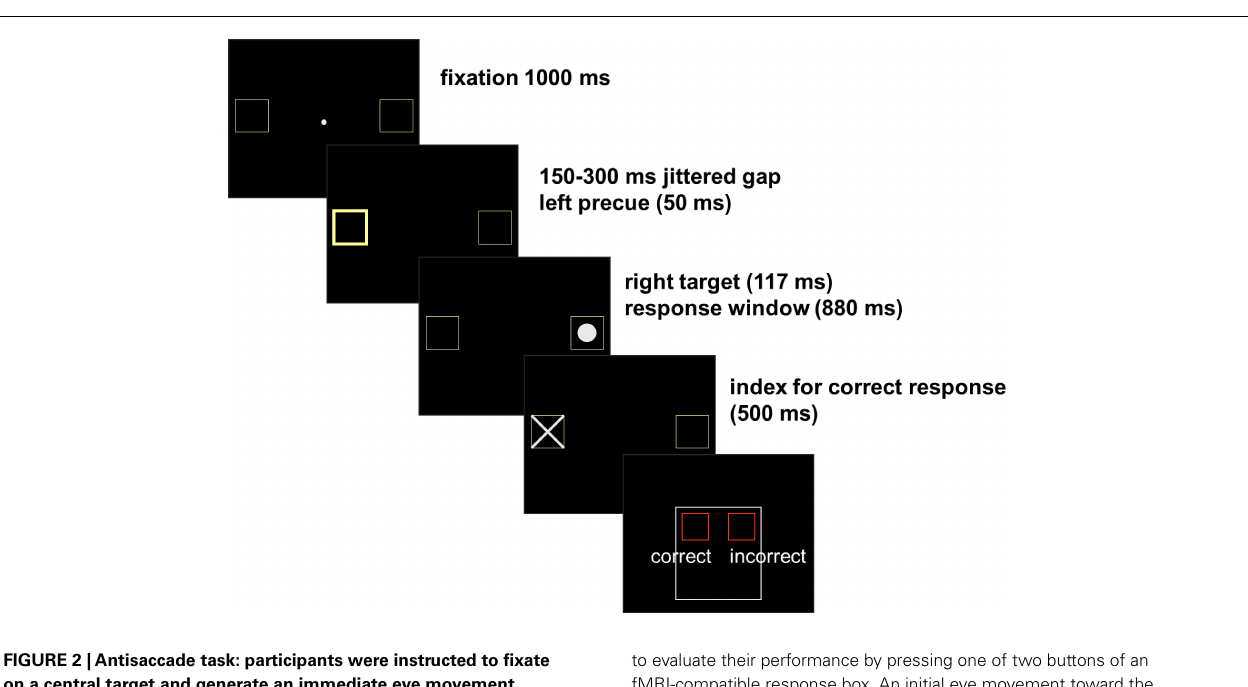
FIGURE 2 |Antisaccade task: participants were instructed to fixate on a central target and generate an immediate eye movement away from an abrupt peripheral target to its mirror location on the opposite side of the screen without making an eye movement to the peripheral target itself. After the response a cross appeared in the correct square indicating the correct gaze direction. Participants were